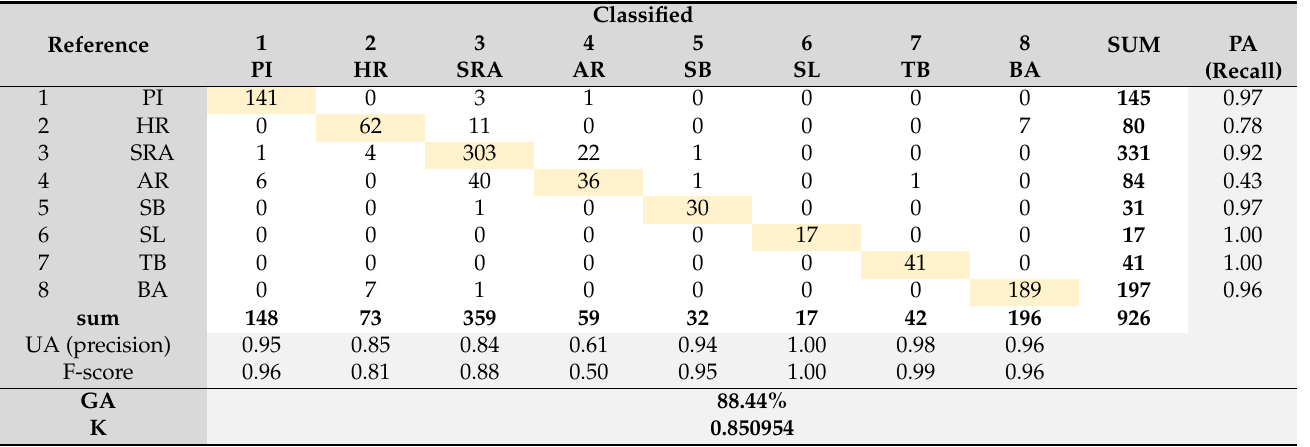
Table 12. Confusion PEST area matrix of classification. The lines represent the reference map. The classes are 1— Pinus sp. (PI), 2—herbaceous restinga (HR), 3—shrub–arboreal restinga (SRA), 4—arboral restinga (AR), 5—shade (SB), 6—bare soil (SL), 7—trunks and branches (TB), and